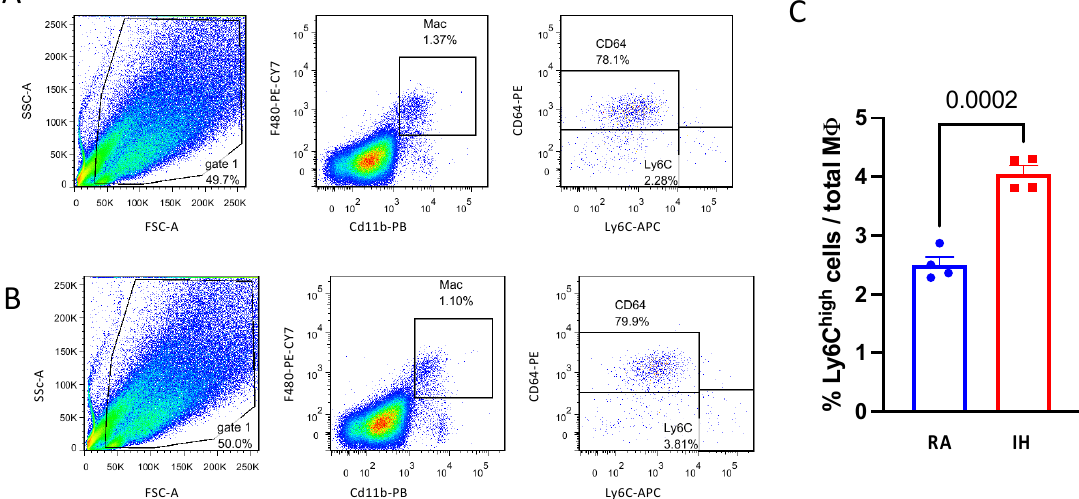
Figure 4. Chronic intermittent hypoxia promotes pro-inflammatory macrophage infiltration into interscapular BAT. ( A ) Representative flow cytometry images of macrophages isolated from BAT of RA or ( B ) IH mice—gated as CD11b/F480 double-positive cells (middle panel) and further stained with anti-CD64 (resident, anti-inflammatory) and anti-Ly6c (bone-marrow derived, pro- inflammatory) antibodies. ( C ) Quantification of the Ly6C high macrophages in BAT demonstrated an increased percentage in IH. Note that the majority of CD64+ macrophages were Ly6C low and vice versa. The percentage of macrophages and the CD64+ subpopulation was not different between the experimental conditions ( n = 4). Pairwise comparisons were performed using Student’s t -test. M Φ